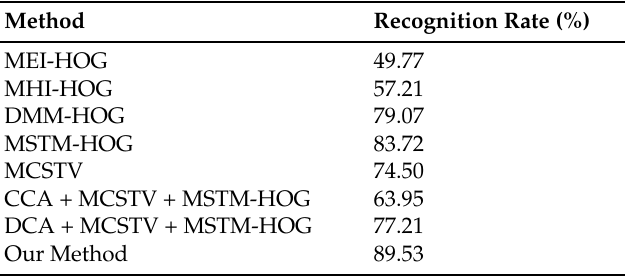
Table 7. The results on UTD-MHAD, according to Setting 2.